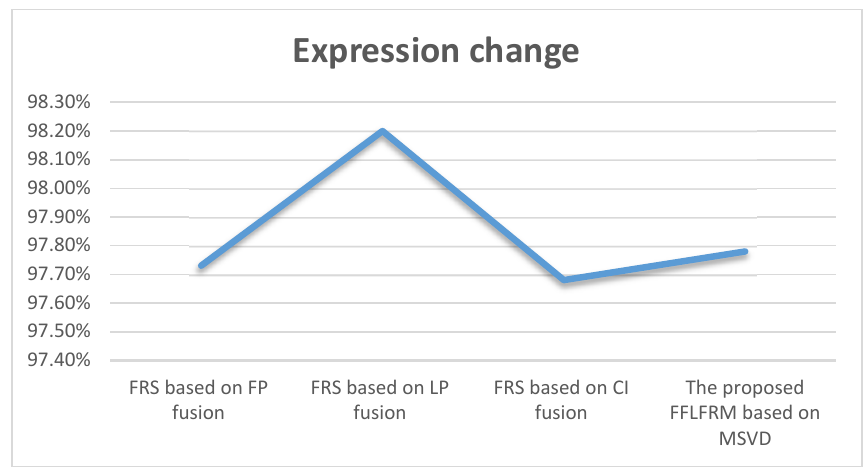
Fig. 6. Recognition accuracies of the four studied FRSs under the condition of face expression change.